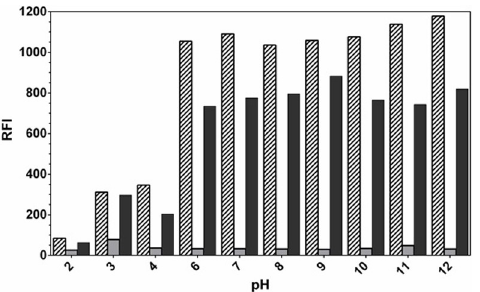
Fig 5. Effect of pH on the RFI values of the interaction mixture of kolliphor RH 40 (2%, w/v) with LAP (1000 ng/ mL). Solid black bars: LAP, solid grey bars: kolliphor RH 40, stripped bars: mixture of LAP and kolliphor RH 40.